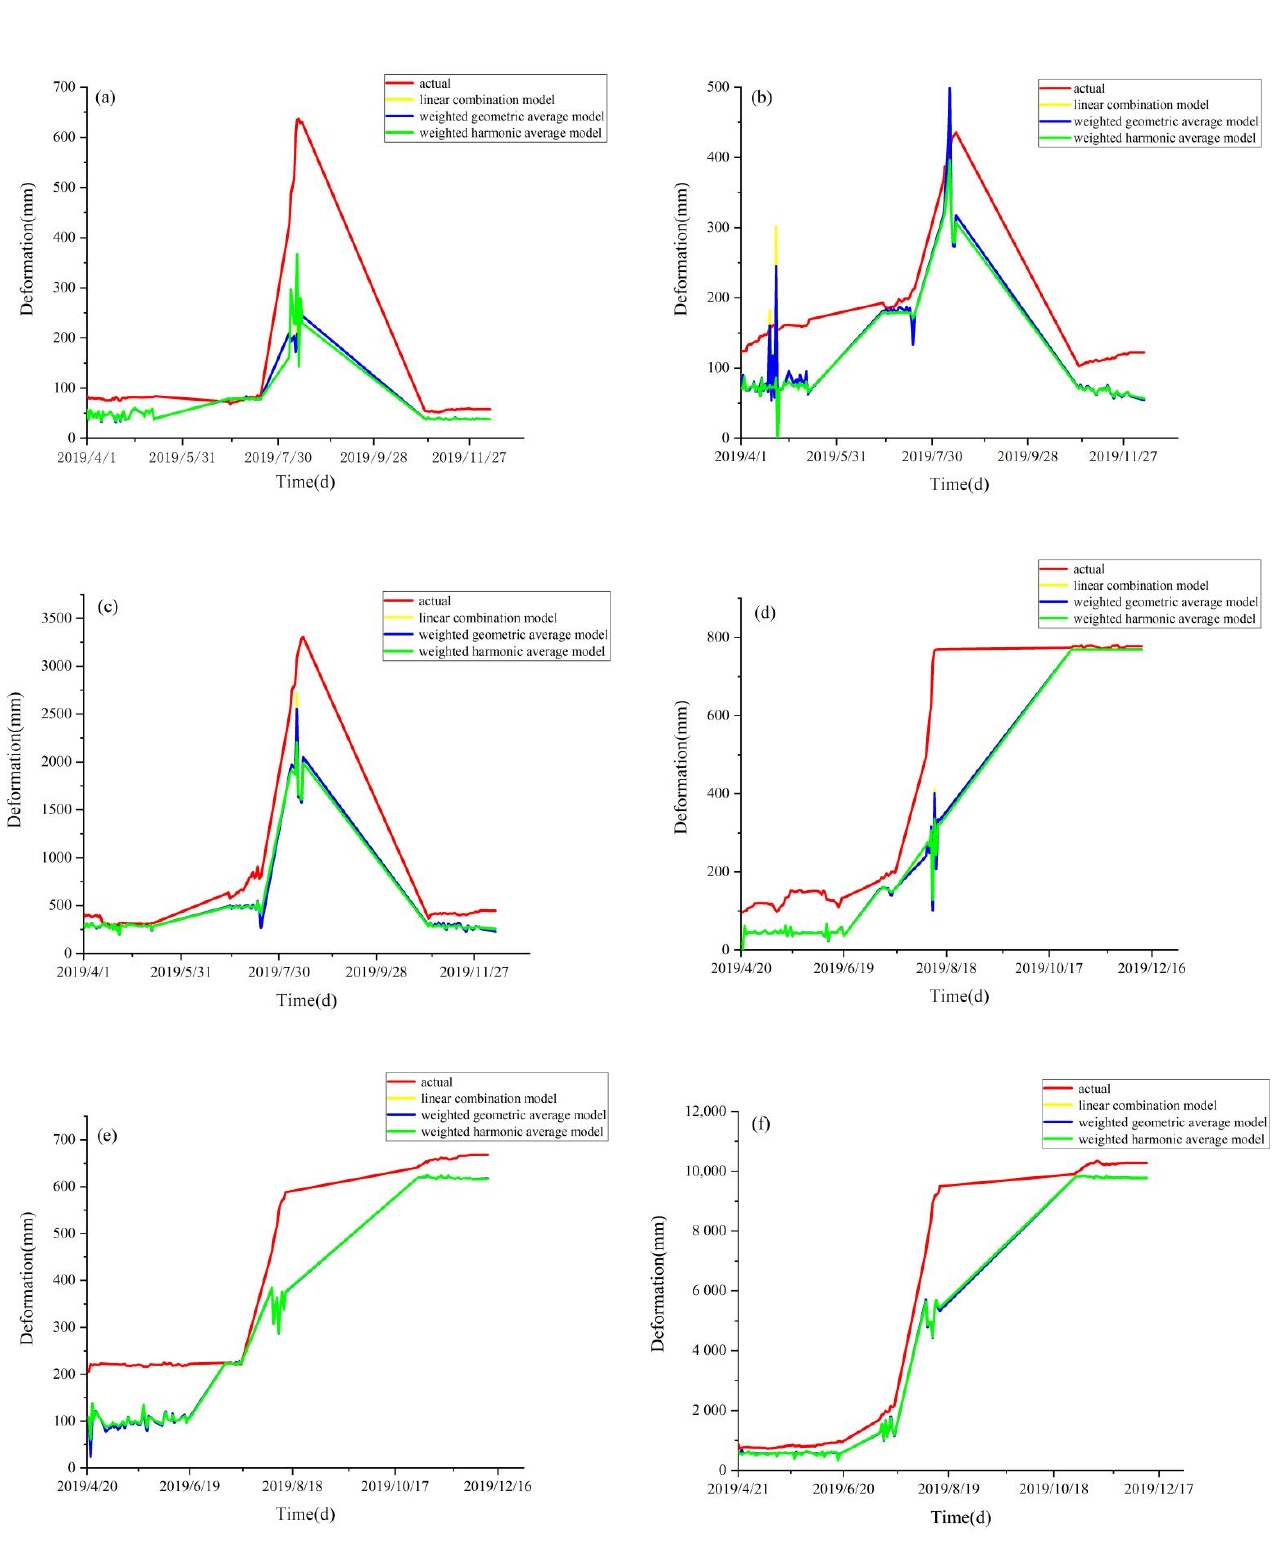
Figure 4. The results of the different prediction combination model at different spatial scales with the different number of grids. ( a ) Point scale and 100 grids; ( b ) linear scale and 100 grids; ( c ) surface scale and 100 grids; ( d ) point scale and 200 grids; ( e ) linear scale and 200 grids; and ( f ) surface scale and 200 grids.